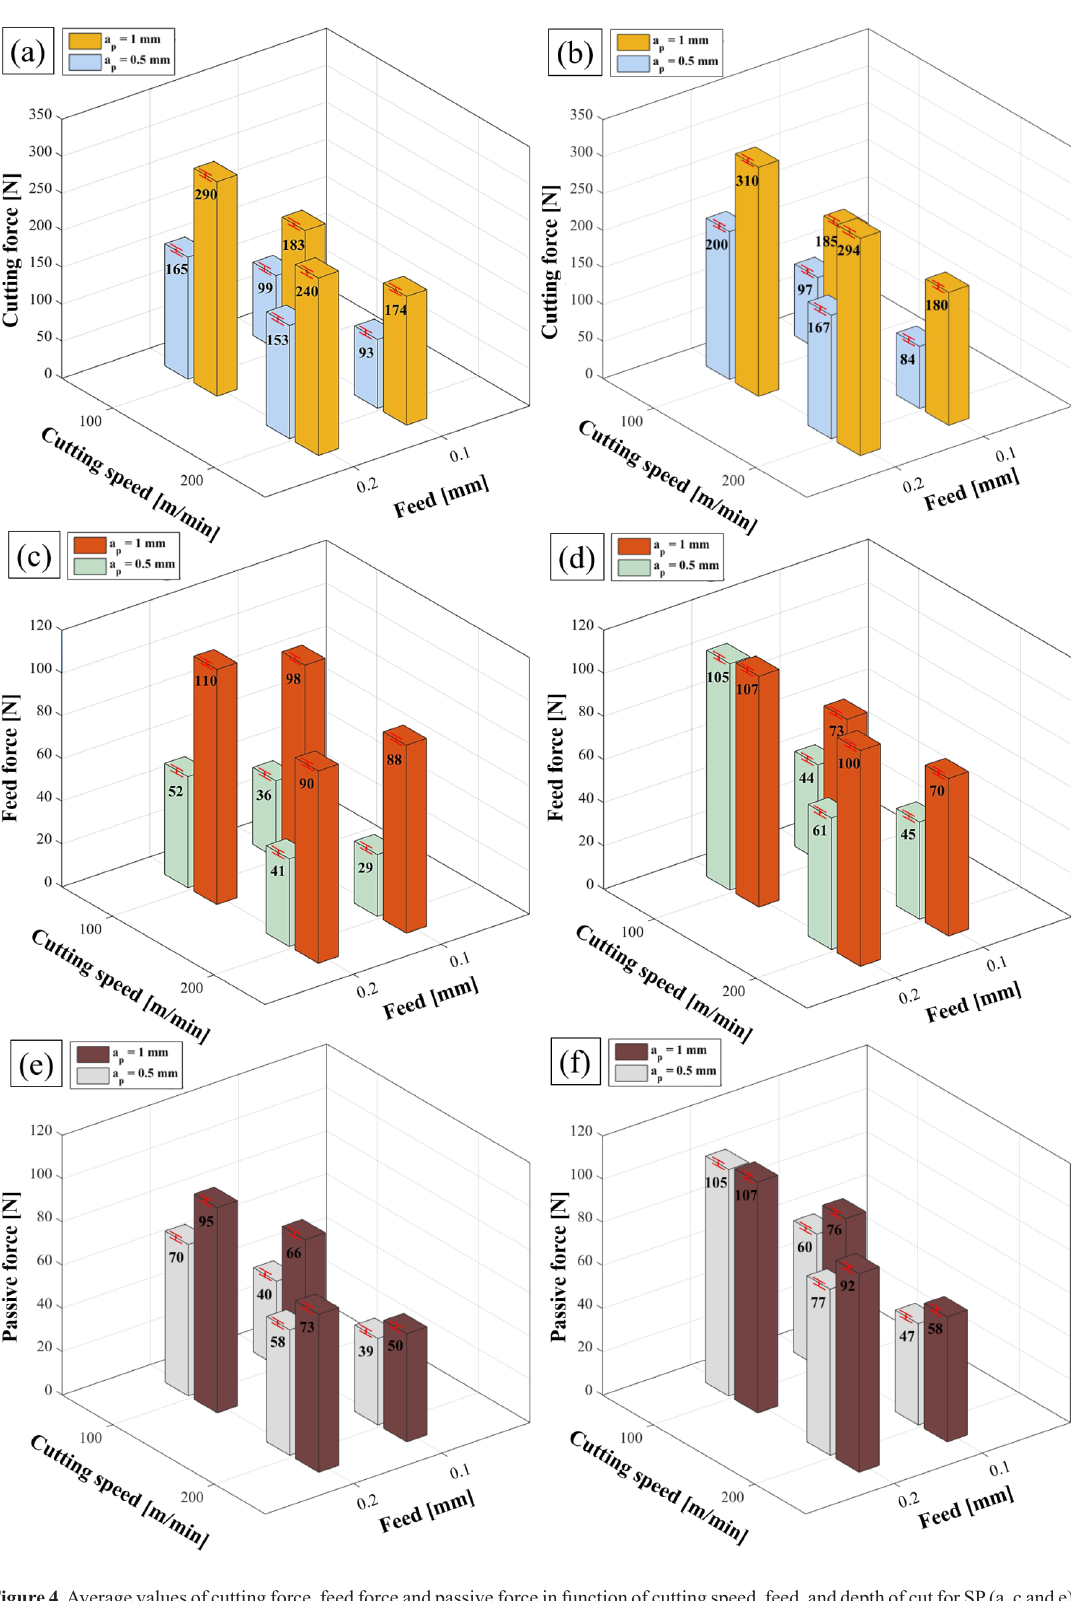
Figure 4. Average values of cutting force, feed force and passive force in function of cutting speed, feed, and depth of cut for SP (a, c and e) and DP materials (b, d and